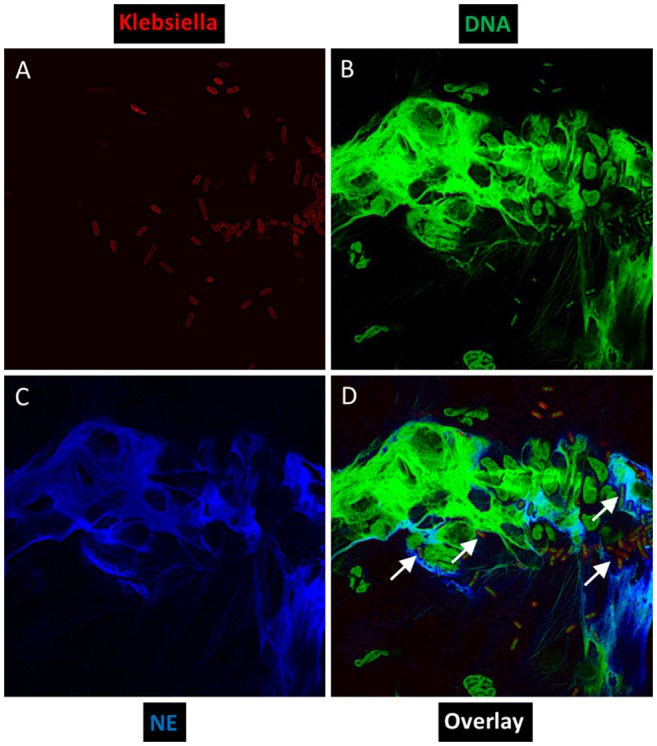
Ex vivo NET formation by neutrophils isolated from a KLA patient after stimulation with hvKP. Neutrophils were exposed to a capsule type K1 strain at an MOI of 1:1 for 2 h, and representative immunofluorescence images were taken at a magnification of 100×. (A) Bacteria were stained red with mouse anti-Klebsiella spp. (primary) and Alexa Fluor 633-conjugated goat anti-mouse (secondary). (B) DNA was stained green with Sytox Green. (C) Human neutrophil elastase (NE) was stained blue with rabbit anti-NE (primary) and Pacific Blue-conjugated goat anti-rabbit (secondary). (D) To visualize co-localization of NET components and hvKP, images from each channel were merged. White arrows point to physical entrapment of hvKP within NETs.